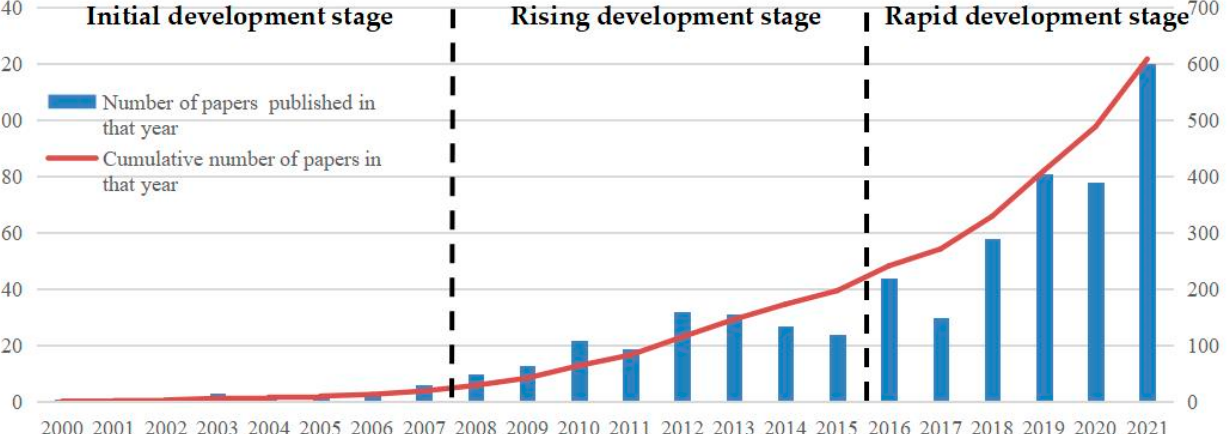
Figure 1. The annual number and stage distribution of China’s dynamic disaster monitoring and early warning international research (2000–2021).